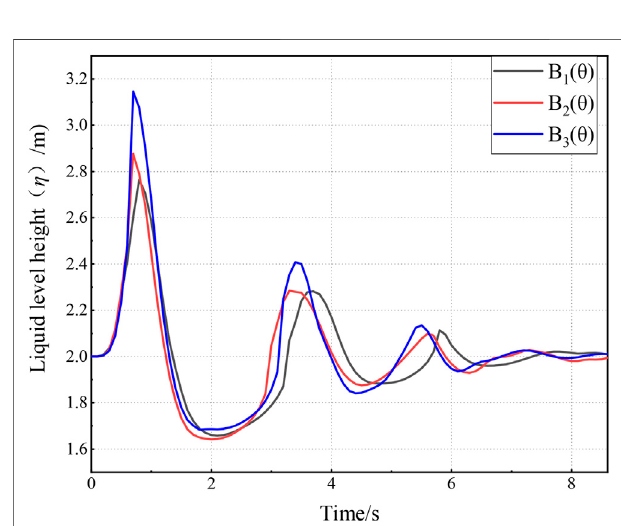
FIGURE 9 | Slide block shape